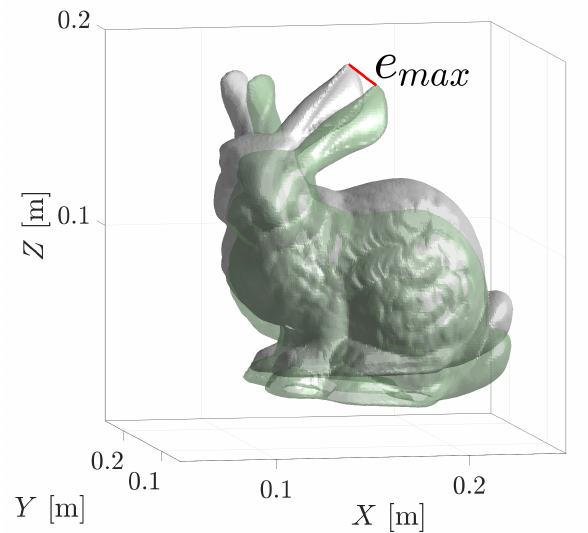
Figure 6. The accuracy of a pose estimate is measured using the maximum vertex error metric, e max , as displayed by the red line. This distance is the maximum displacement of the geometries between the estimate (green) and the correct pose